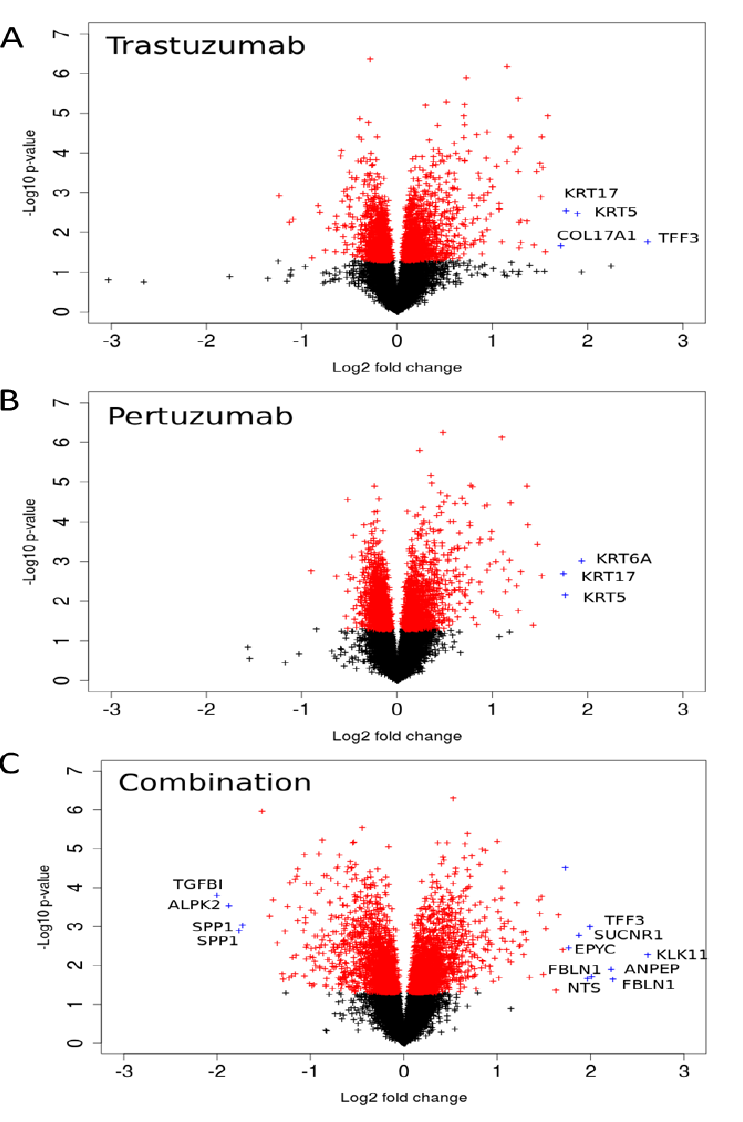
Figure 6. Volcano-plots of gene expression following trastuzumab ( A ), pertuzumab ( B ), and their combination ( C ) treatment of SKOV3 ovarian xenograft tumour [28]. The genes with statistically significant ( p -value < 0.05) and non-significant fold changes are coloured by red and, black, respectively. Genes with a high fold change are marked by blue